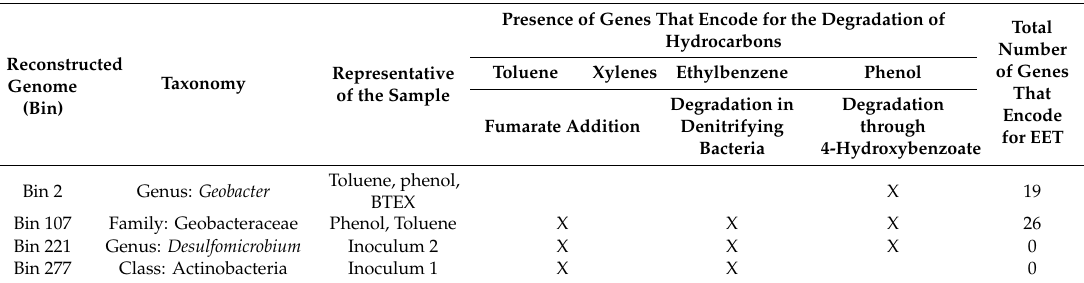
Table 3. Characteristics of reconstructed genomes: hydrocarbon degradation and extracellular electron transfer (EET)